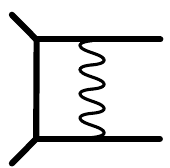
Figure 5 . String generating BPS particle with spin ( j